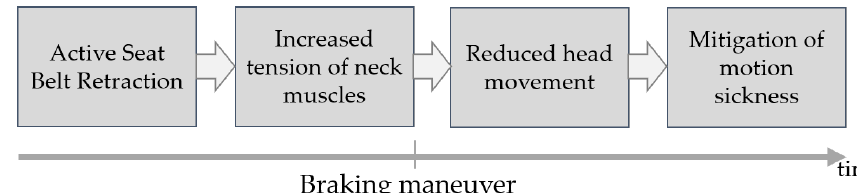
Figure 1. Illustration of examined hypotheses.